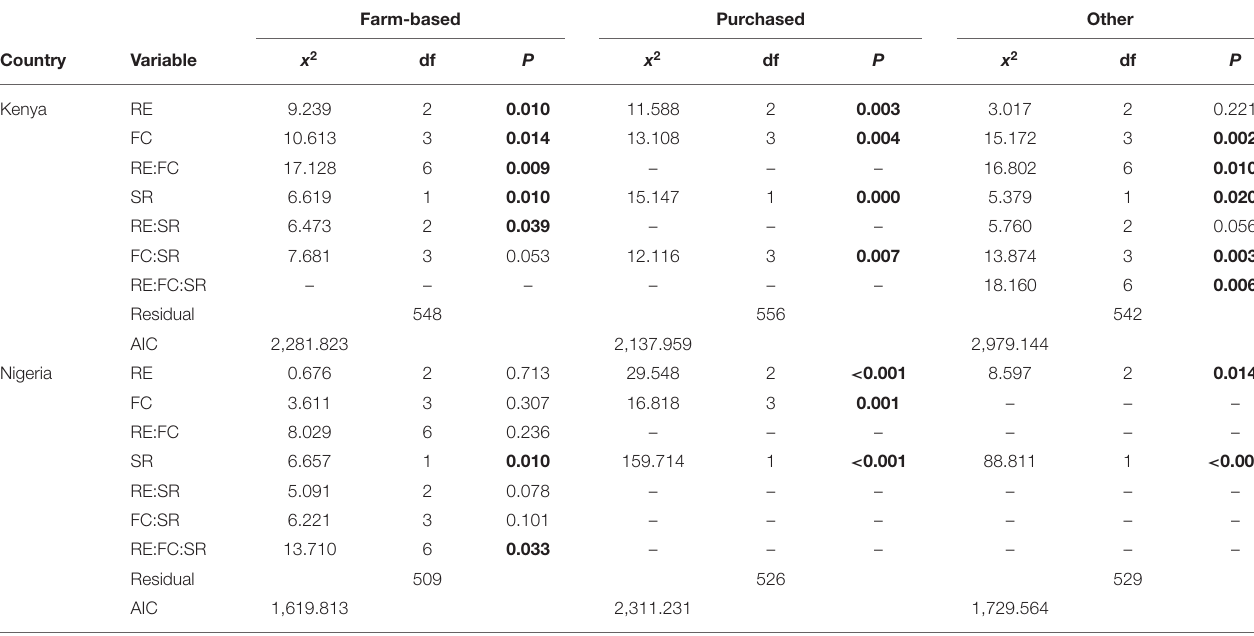
TABLE 6 | Model fitting results showing the fitted effects of RE and FC groups and species richness for the three dietary diversity sources (purchased, farm-based and “other”), for the final reduced models. Farm-based Purchased Other Country